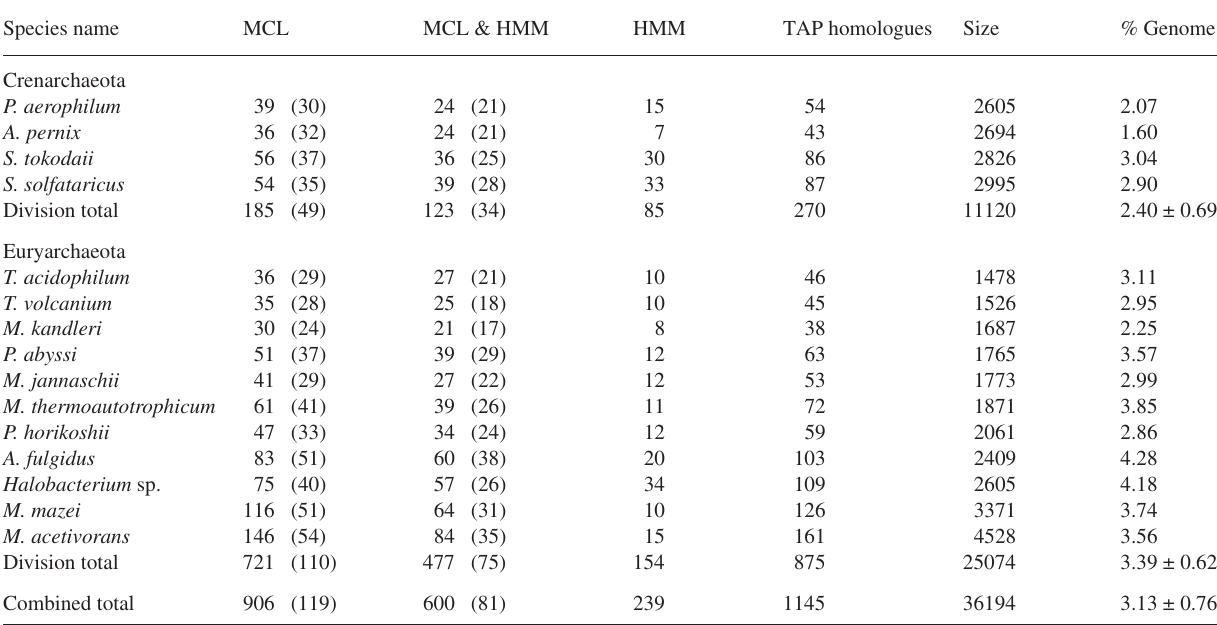
Table 4. TAP-homologue abundance in the Crenarchaeota and Euryarchaeota genomes. Definitions: MCL, the number of TAP-homologues de- tected by the TRIBE-MCL clustering; MCL & HMM, the number of TAP-homologues detected by both the TRIBE-MLC and the profile-HMM searches (the number of families in which these homologues are detected is shown in brackets); HMM, number of sequences that match only the TA-HMMs; TAP homologues, number of genes encoding TAP-homologues; Size, the number of protein sequence entries; % Genome, the per- centage of genes identified as TAP-homologues. Totals for % Genome are shown ± the standard deviation.